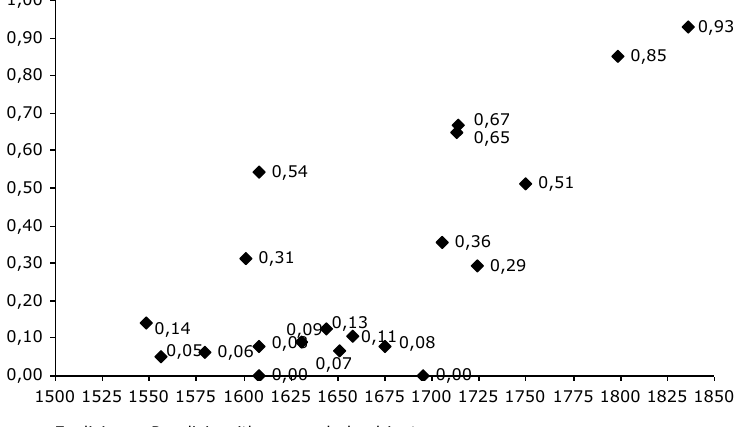
1500 1525 1550 1575 1600 1625 1650 1675 1700 1725 1750 1775 1800 1825 1850 Enclisis vs. Proclisis with pre-verbal subjects Galves, Britto & Paixão de Sousa, 2005Galves, Britto & Paixão de Sousa,